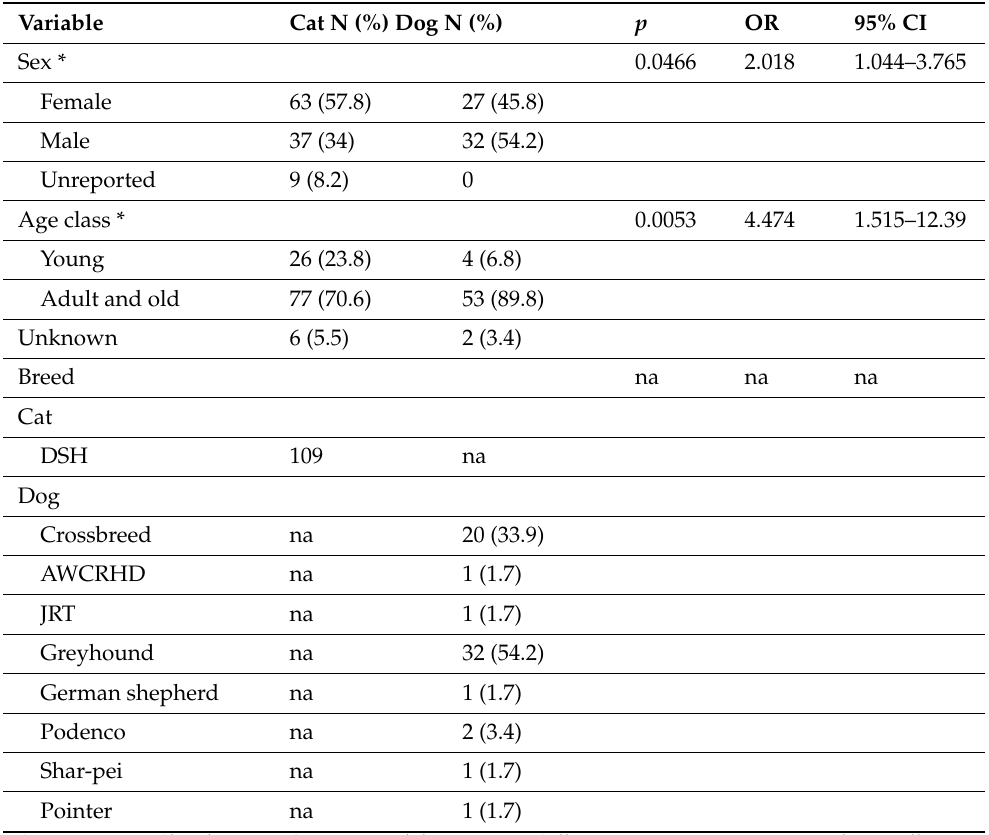
Table 1. Demographic data of enrolled animals and p values for significant differences between dogs and cats.